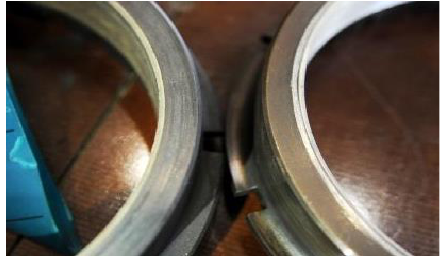
Appl. Sci. 2022 , 12 , x FOR PEER REVIEW Figure 10. The fatigue damage of the shaft. Figure 10. The fatigue damage of the shaft.